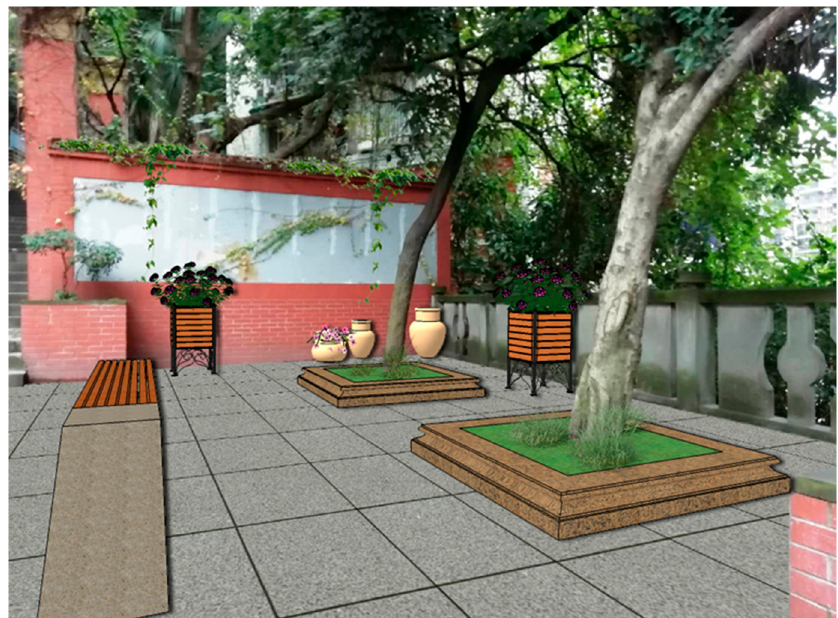
Figure 3. The preliminary design proposal for a typical public space of community planning.